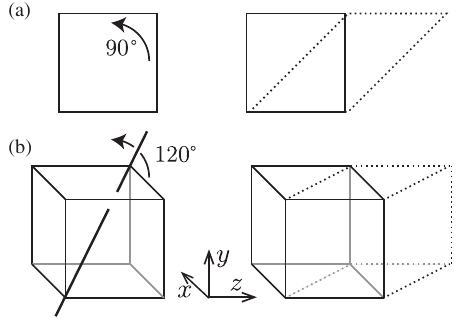
FIG. 1. S (left) and T (right) transformations on the (a) two- torus and (b) three-torus, which are defined by periodic boundary